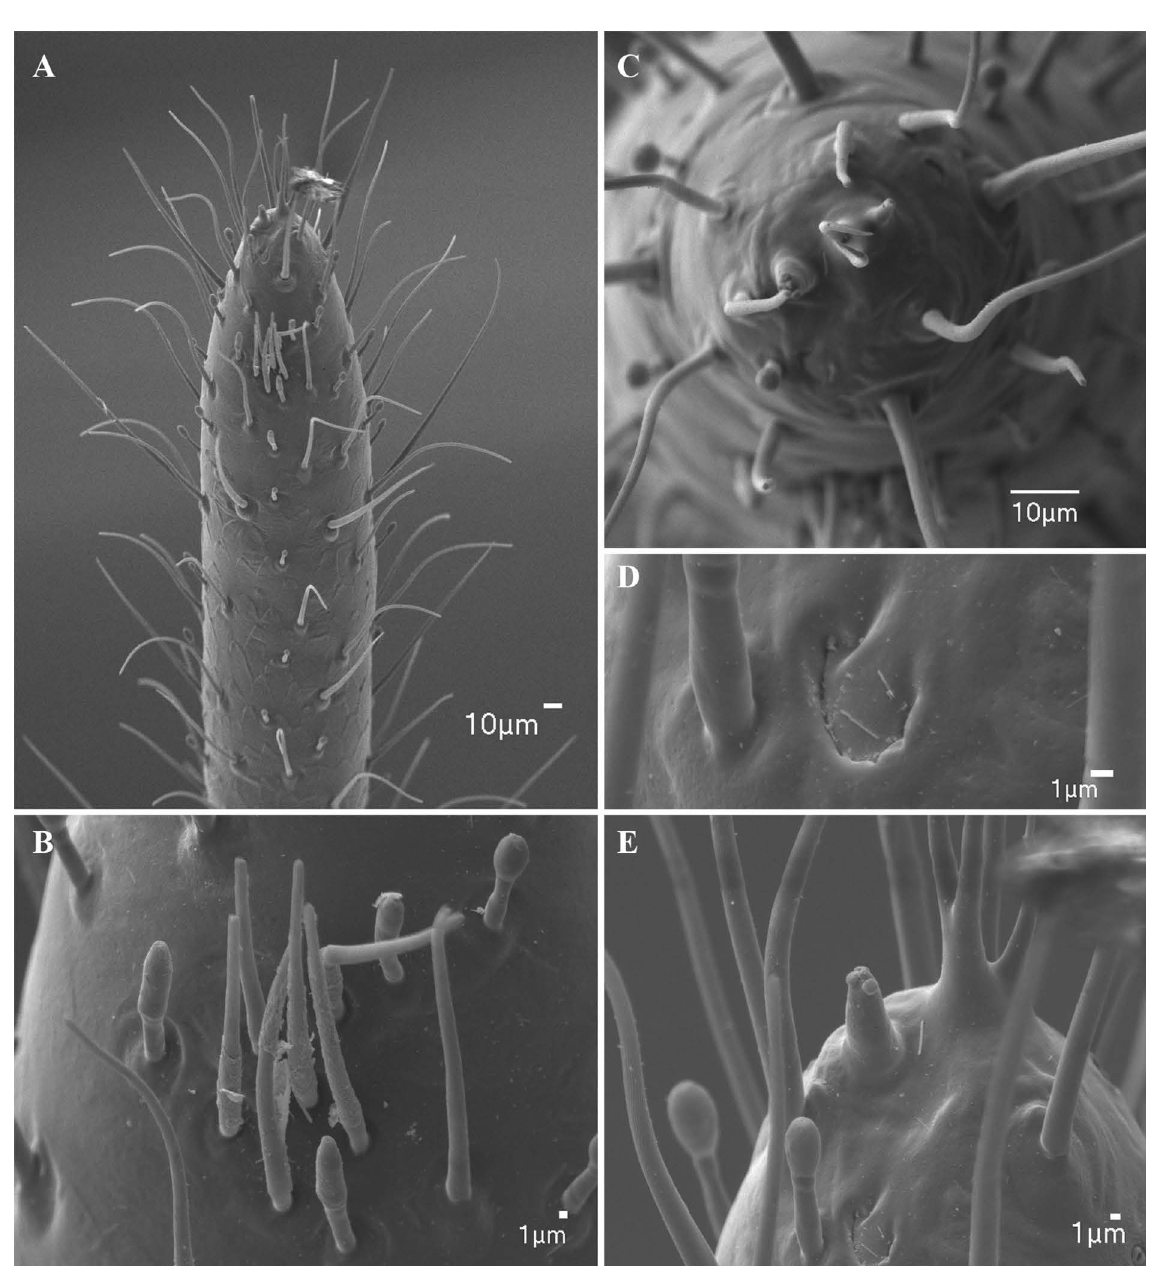
Fig. 63. Charinus euclidesi sp. nov. (MNRJ 9099), antenniform leg I. A . Apex of distal article. B . Rod sensilla and olfactory setae. C . Apex of distal article of tarsus showing claw and tarsal organ. D . Detail of slit sensilla. E . Distal segment of tarsus,